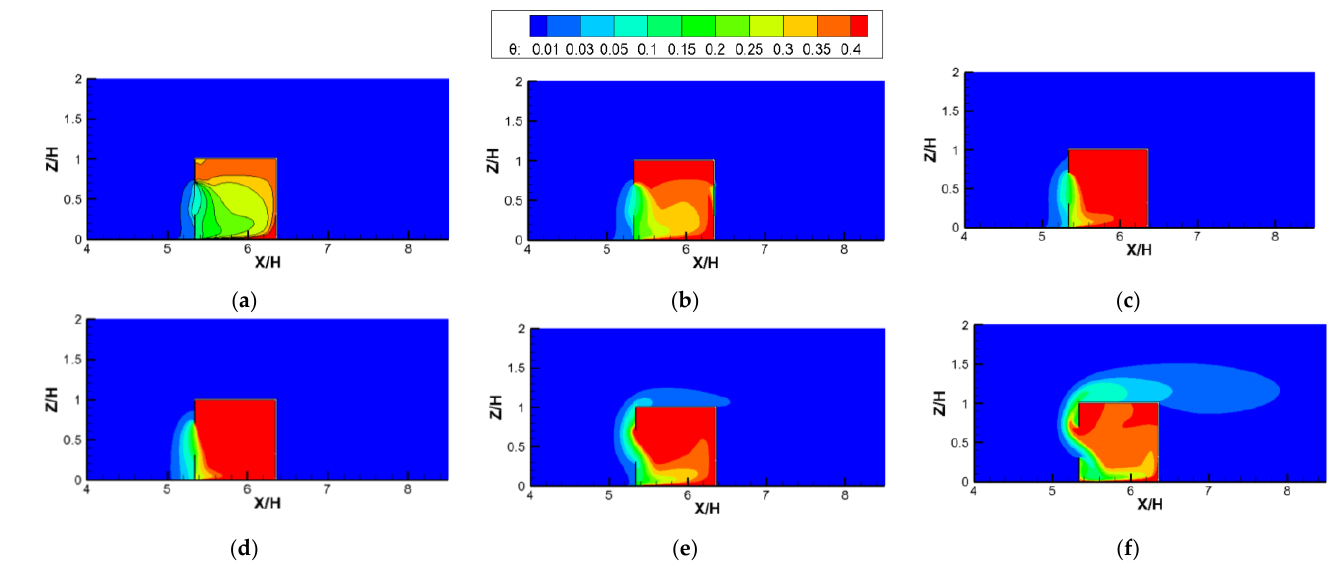
Figure 12. Contours of dimensionless temperature ( θ ) against increasing Ri values for single-sided ventilation cases. ( a ) Ri = 0.04; ( b ) Ri = 0.27; ( c ) Ri = 1.86; ( d ) Ri = 5.31; ( e ) Ri = 11.11; ( f ) Ri = 26.65.